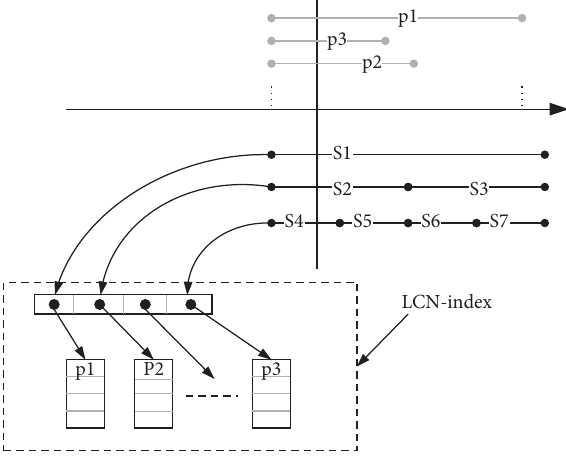
Figure 6: Example of LCN-Index Search operation; search is performed via the SIUs.